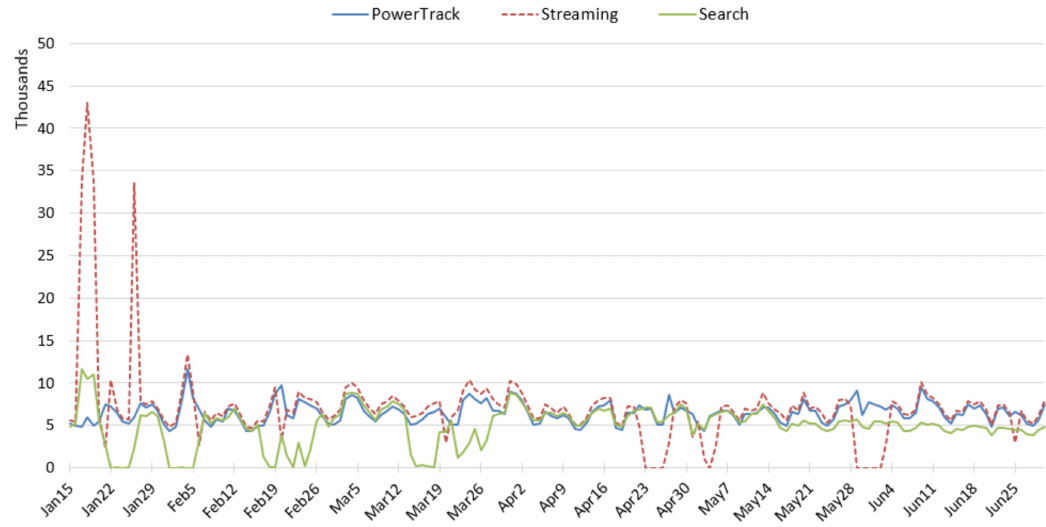
Figure 4. Daily amount of e-cigarette-related tweets across the APIs.